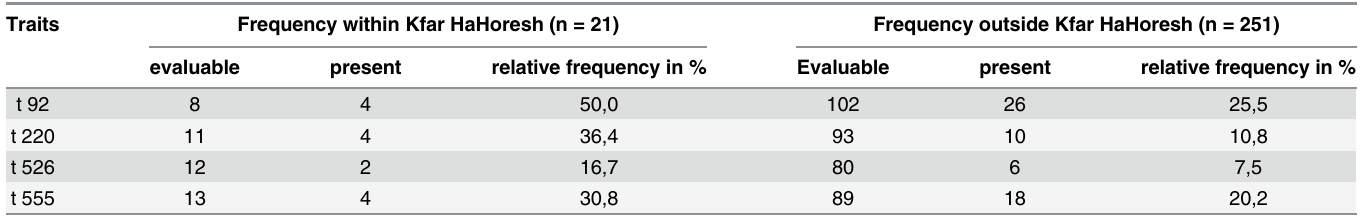
Table 3. Four traits with increased frequency in Kfar HaHoresh and their relative frequencies within the population of Kfar HaHoresh and within the reference population. Traits Frequency within Kfar HaHoresh (n =